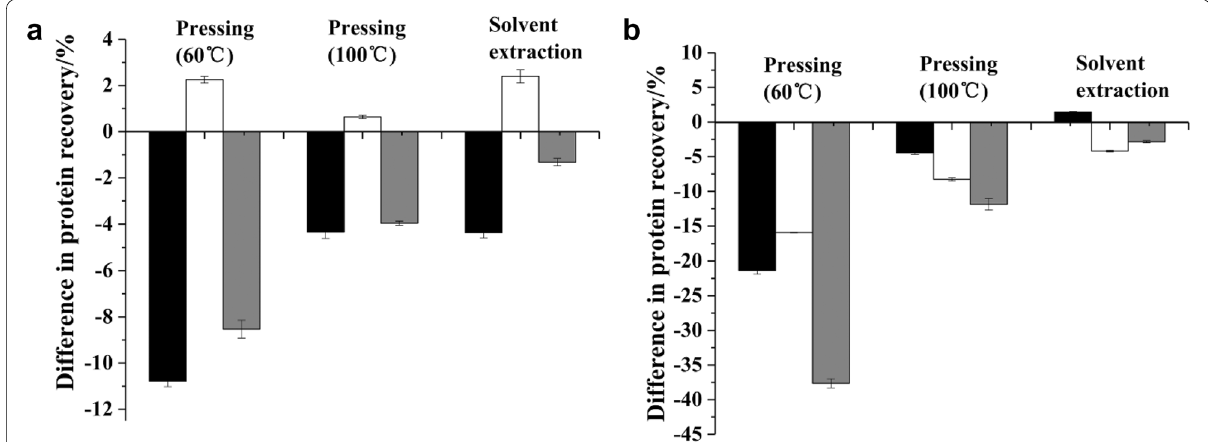
Fig. 4 Differences in protein recovery from increasing the pre-dried temperature from 60 ℃ to 105 ℃ ( ) and from increasing the protein extraction temperature from 25 to 60 ℃ ( ), grey bars ( ) indicate the net influence. a protein extraction by water–alkaline–alkaline treatment; b Protein extraction by enzymatic